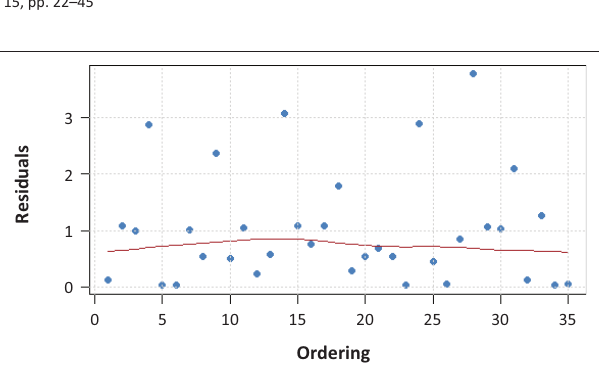
FIGURE 6: South Africa – Histogram of the exchange market pressure index for 1999–2017.